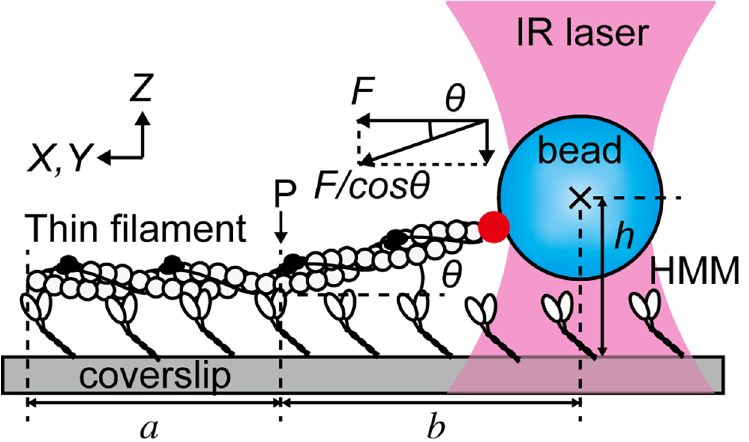
Fig 1. Schematic illustration of the in vitro motility assay system showing the parameters considered. A reconstituted thin filament (actin is illustrated by open circles, Tpm thin curved lines, and Tn black spheres) attached to a polystyrene bead (1.0 µm in diameter) via gelsolin (red sphere) was manipulated by optical tweezers. In the presence of ATP, the thin filament was interacted with HMM molecules that were attached to the surface of a collodion-coated glass coverslip. The region indicated by a , the part of the thin filament which interacted with HMM molecules that was visualized with the total internal reflection fluorescence (TIRF) microscopy system. The region indicated by b , the distance between the center of the bead and the end of the thin filament interacting with HMM ( P ), was determined from the epifluorescence microscopy. θ , the angle between the thin filament and the glass surface at P , determined geometrically from the distance of the bead from the glass surface ( h ) and b as θ = arctan ( h / b ).The actual size of HMM is small enough to be ignored compared to h (see text). Sliding force in horizontal direction ( F ) was obtained from the trap stiffness (range: 0.042 pN/nm to 0.15 pN/nm) and the displacement of the bead in the X - Y plane. The corrected force vector was calculated as F /cos θ .